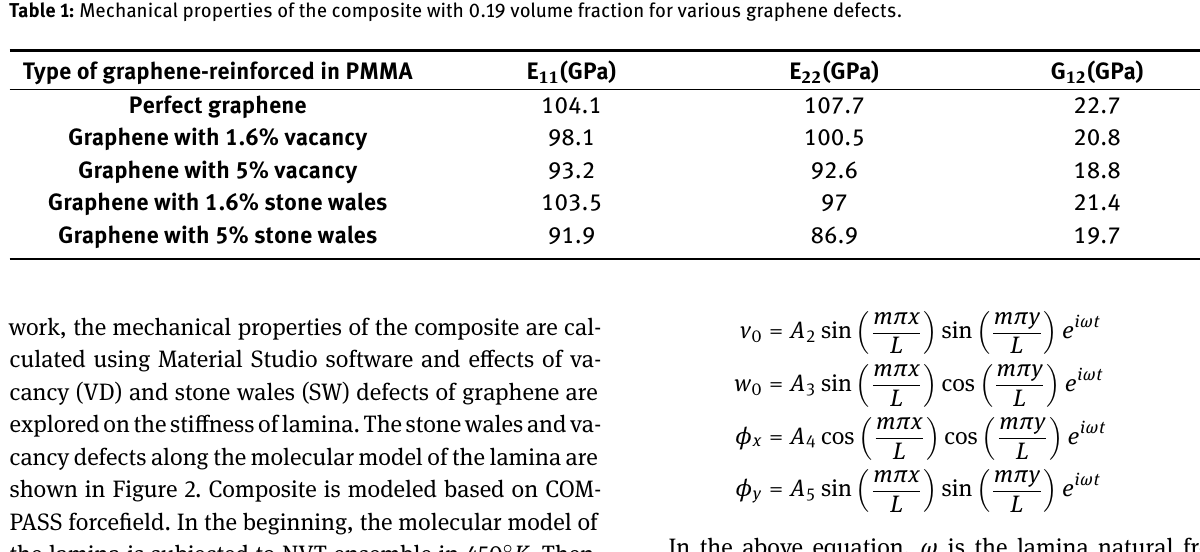
Table 1: Mechanical properties of the composite with 0.19 volume fraction for various graphene